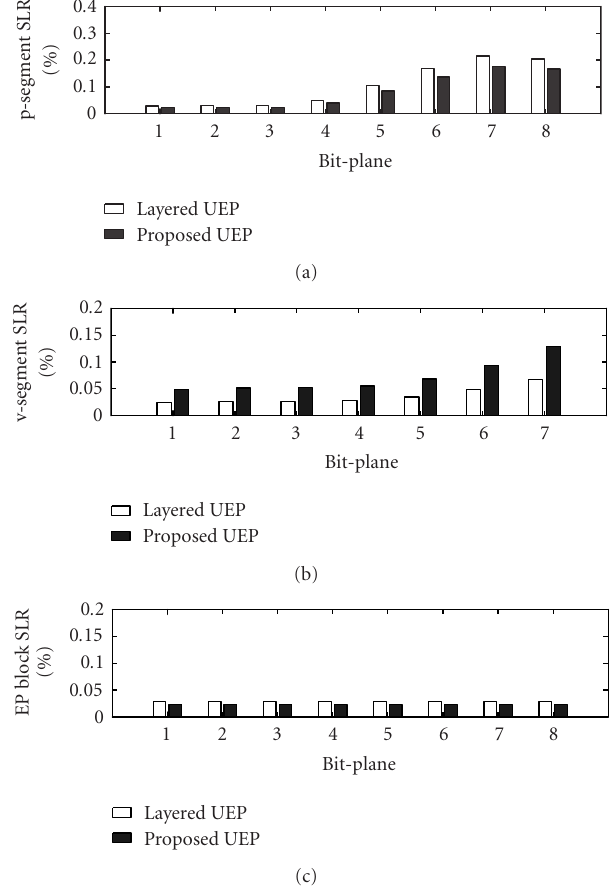
Figure 8: Segment loss ratio (SLR) of EP blocks, p-segments, and v-segments, for the scenario of 0.008 mJ energy